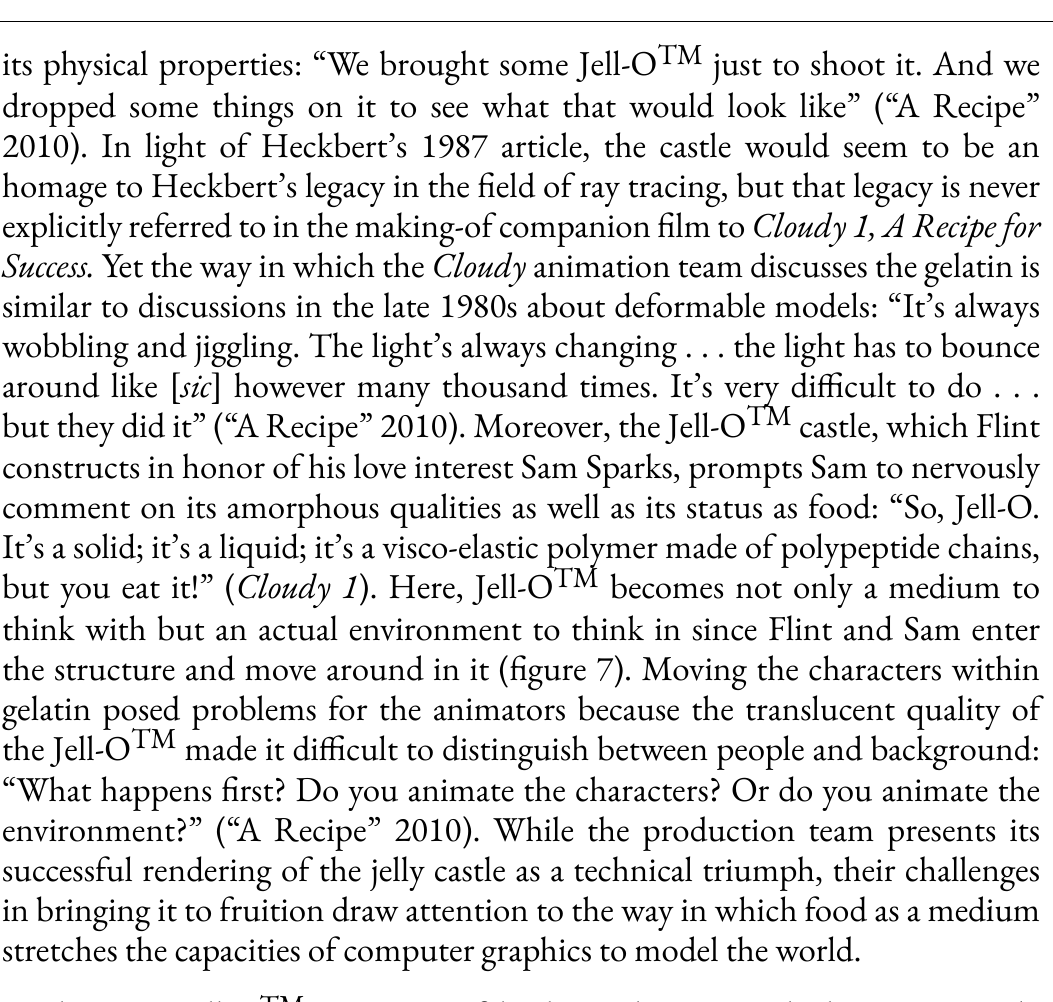
Figure 7: Sam and Flint swimming in the jelly castle ( Cloudy 1